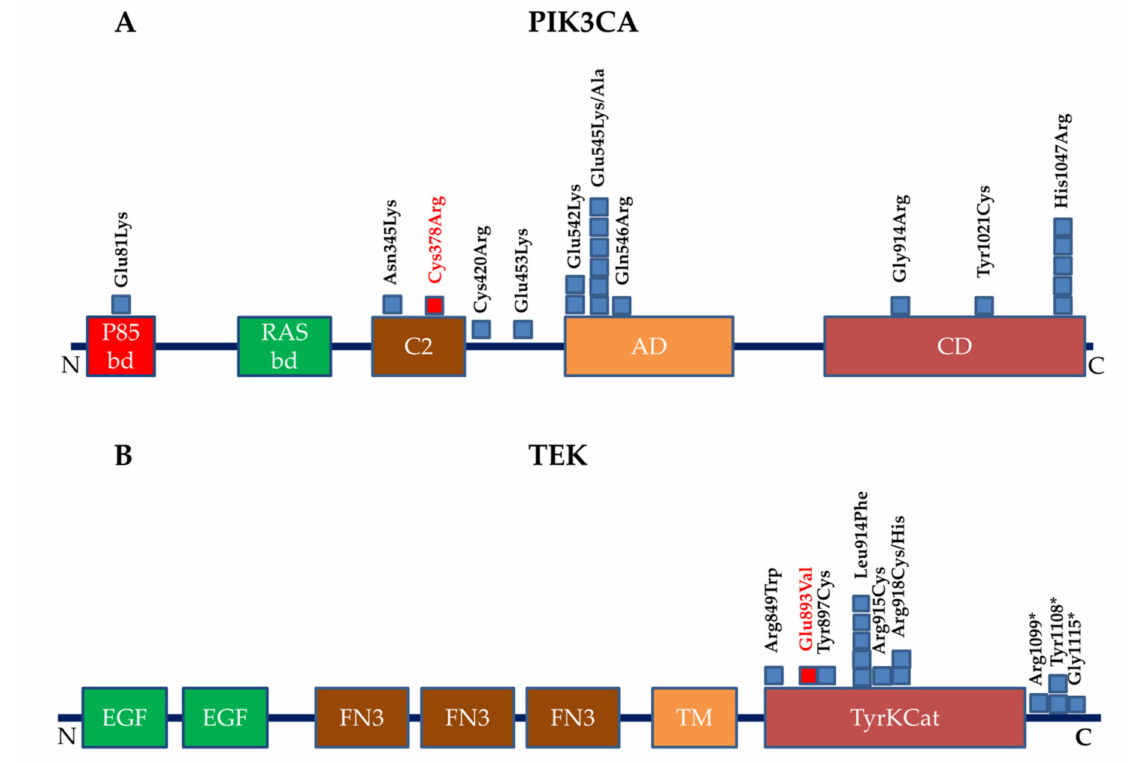
Figure 2. ( A , B ) schematic representation of the PIK3CA and TEK domains a ff ected by the mutations that we found in this study (the squares indicate the variants found). The novel variants reported here are in red. p85bd = p85–binding domain; RASbd = Ras–binding domain; C2 = Protein kinase C conserved region 2; AD = Accessory domain; CD = catalytic domain; EGF = Epidermal growth factor–like domain; FN3 = Fibronectin type 3 domain; TM = Transmembrane domain; TyrKCat = Tyrosine kinase, catalytic